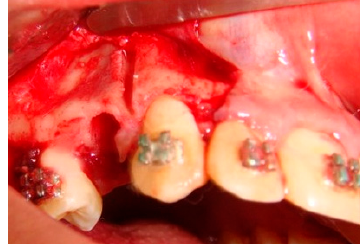
Figure 1. Surgical site partial corticotomy.